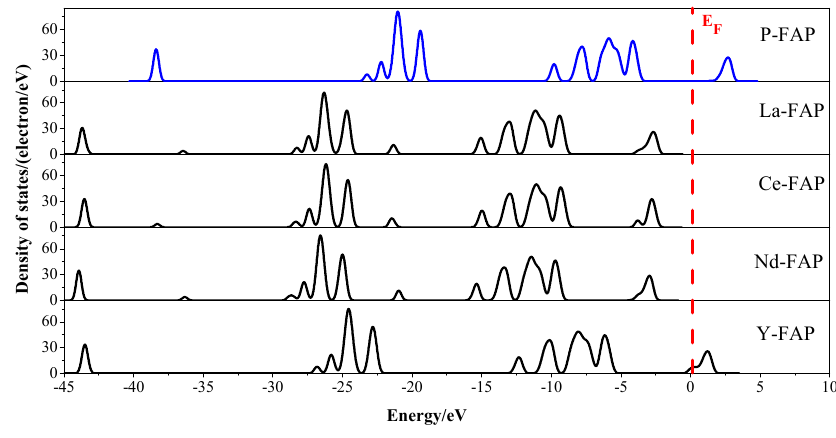
Figure 5. Density of state (DOS) of P-FAP and REE-FAP crystals.